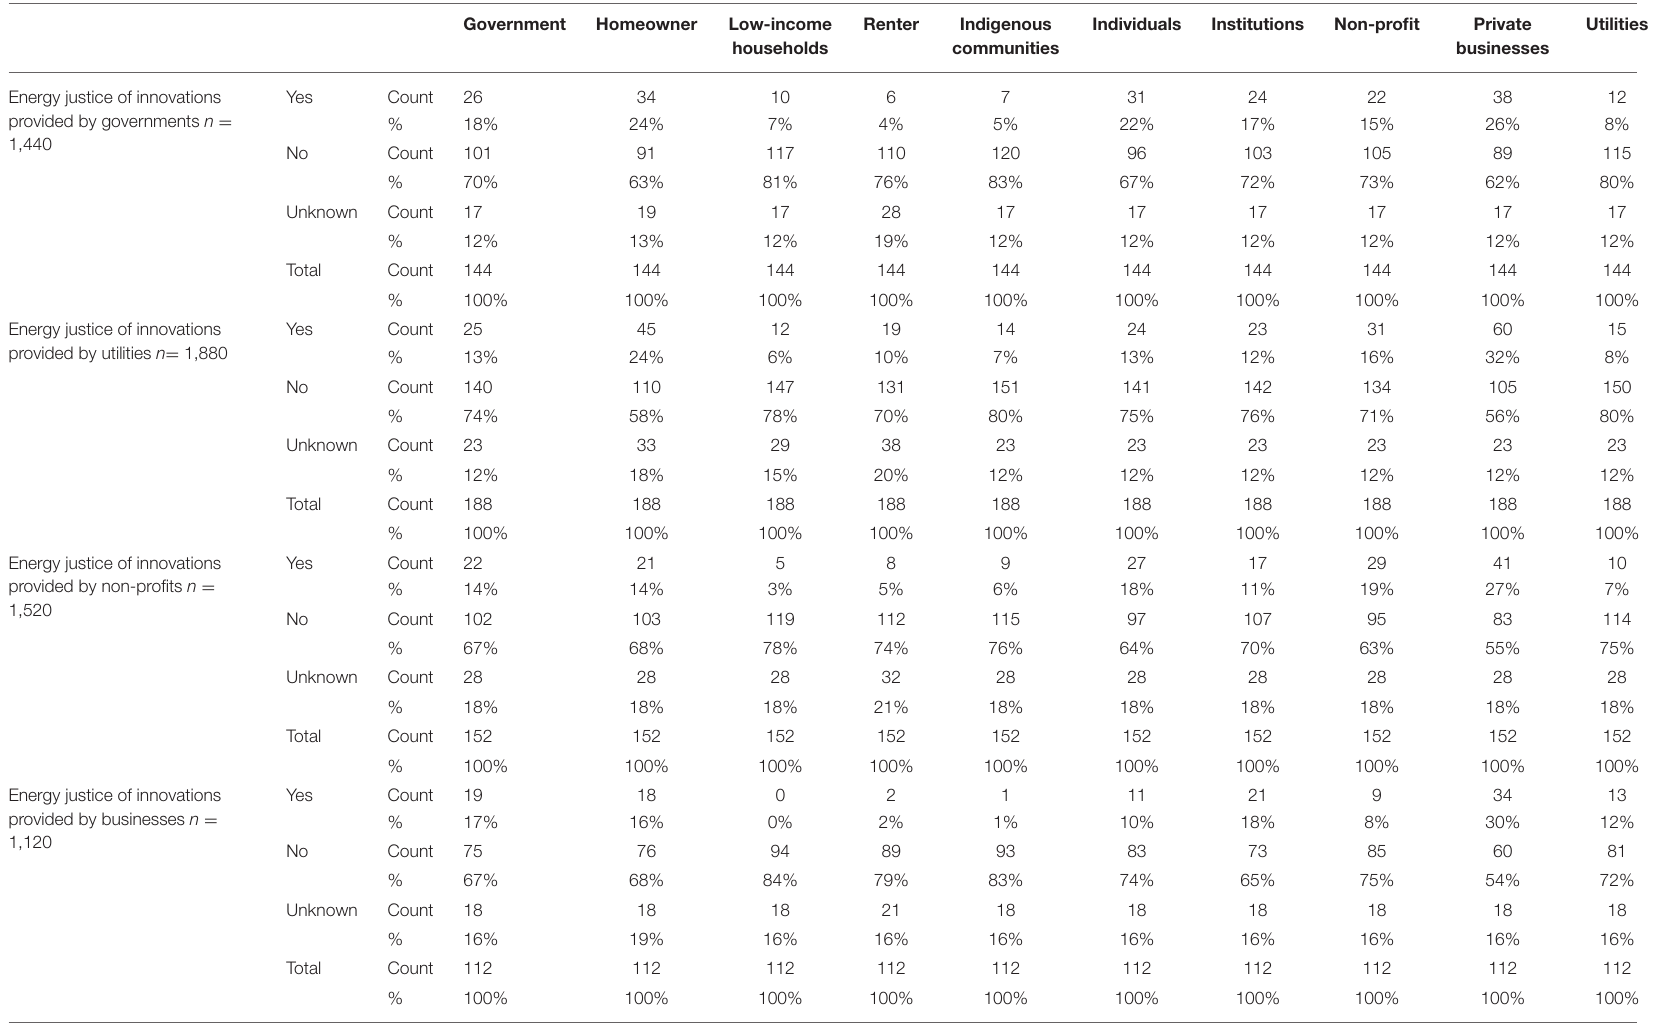
TABLE 7 | Crosstabulation of the presence of energy justice a across innovation users by provider